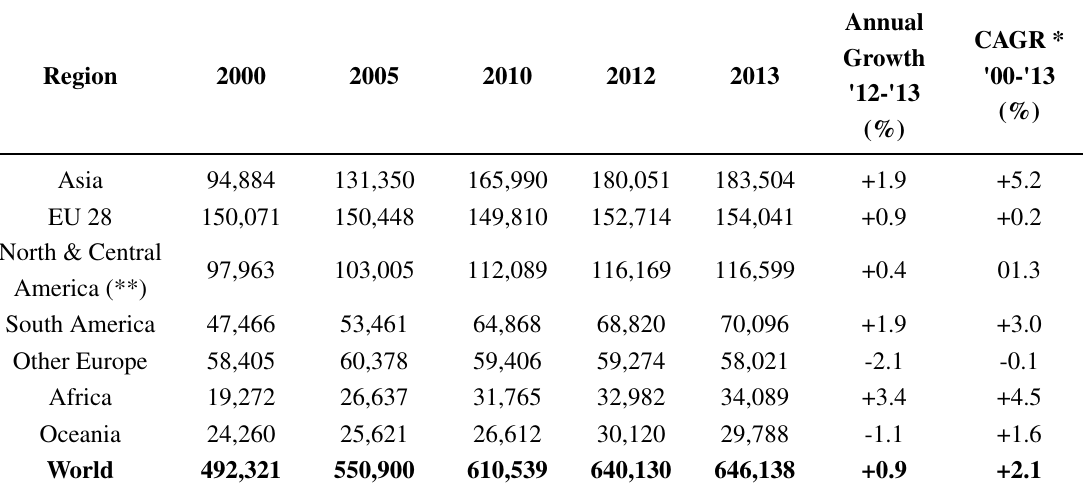
Table 6. World cow’s milk production 2000–2013 (1000 tonnes)